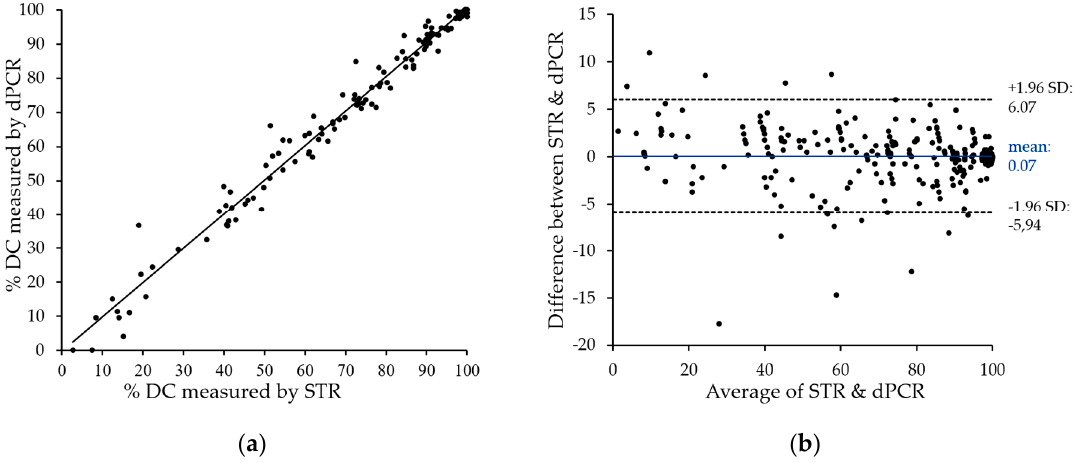
Figure 4. Excellent correlation of chimerism data as obtained on clinical samples by dPCR vs. STR Chimerism was assessed for 147 post-SCT samples by both dPCR and STR analyses. ( a ) Obtained data were analyzed for linear regression of percent donor chimerism (DC) (digital PCR assays are regularly designed to quantify remaining patient cells). As shown, a very high degree of correlation ( r 2 > 0.98) was observed; ( b ) Bland–Altmann analysis of dPCR as compared to STR data. The difference between STR and dPCR quantification is plotted against their mean. Ninety-five percent limits of agreement have been computed by average difference ±1.96× standard deviation (SD) of difference.